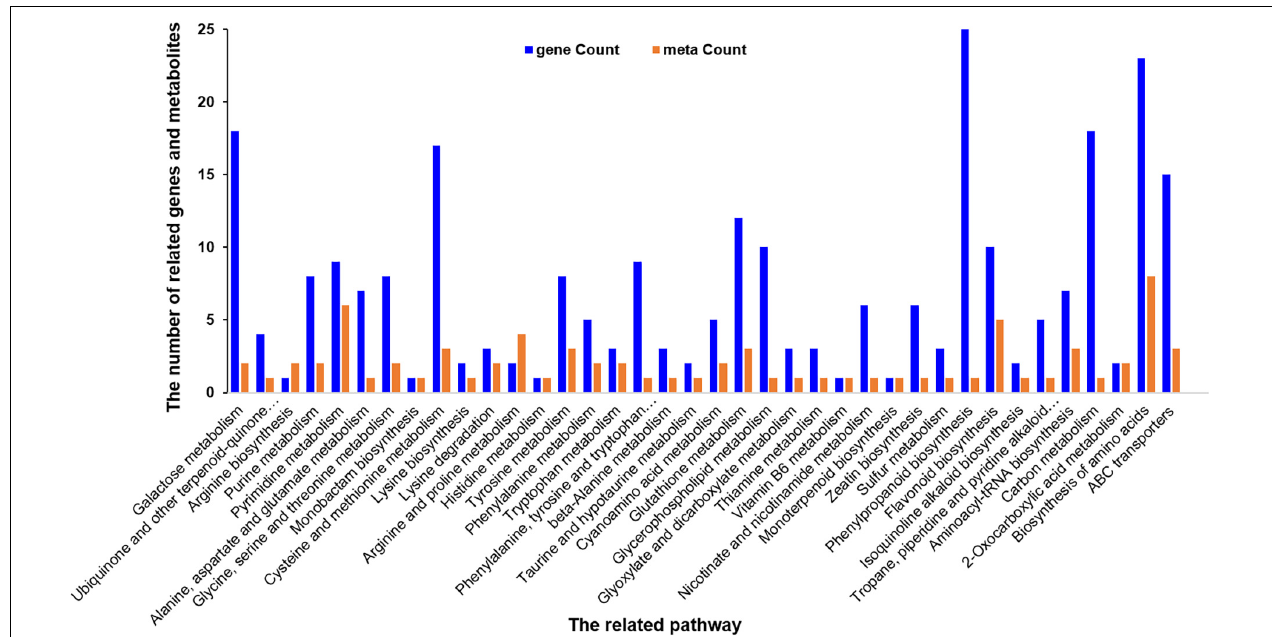
FIGURE 8 | Histogram of the differentially expressed related genes and metabolites in response to ID in A. catechu seedlings